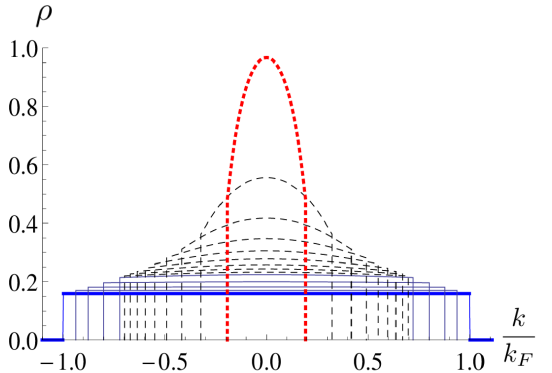
Figure 2: Dimensionless density of pseudo-momenta ρ as a function of dimensionless pseudo- momentum k / k for various interaction strengths. Different colors and line styles represent F results from various approximations. From bottom to top, one sees the exact result in the Tonks-Girardeau regime (blue, thick), then four curves corresponding to dimensionless pa- rameters α = 10, 5, 3 and 2 respectively (solid, blue) obtained from the analytical methods of Appendices C, D and a Monte-Carlo algorithm to solve the Lieb equation Eq. (4) (indistin- guishable from each other). Above, an other set of curves represents interaction strengths from α = 1.8 to α = 0.4 with step − 0.2 (black, dashed) obtained from a Monte-Carlo algorithm and the method of Appendix D, where again analytics and numerics are indistinguishable. Finally, we also plotted the results at α = 0.2 from the method of Appendix D (dotted,